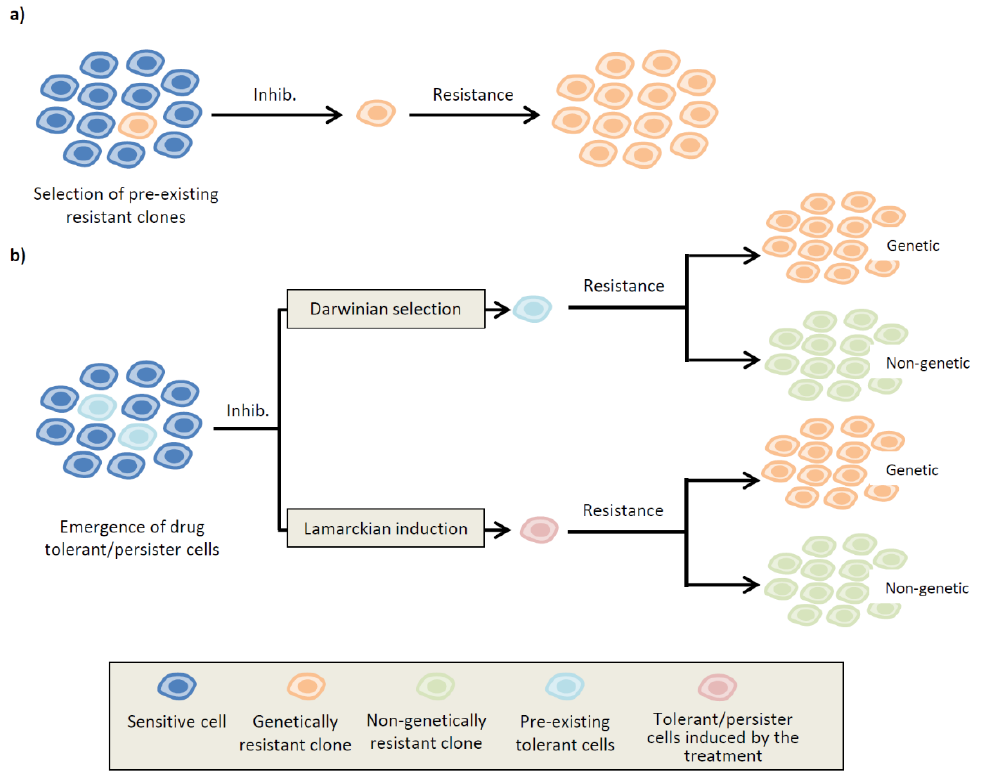
Figure 1. Evolutionary model for the development of drug resistance in cancer cells. ( a ) Rare pre-existing clones containing resistance mutations (orange) are selected in response to treatment with a specific inhibitor (Inhib.). ( b ) Alternatively, resistance may arise from tolerant/persister cells capable of surviving in the presence of the inhibitor (light blue and red) and evolve over time to acquire genetic (orange) or non-genetic resistance (green). These cells are selected because of some intrinsic properties (light blue) through non-genetic Darwinian selection, or they can originate more randomly (red), as a direct effect of the inhibitor (Lamarckian induction).